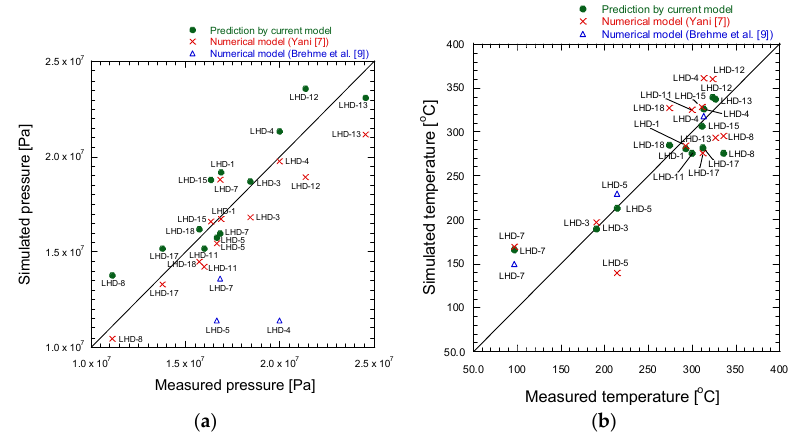
Figure 18. Measured versus simulated results in natural state condition: ( a ) pressure; ( b ) temperature. (Measured data are based on Yani [8]).